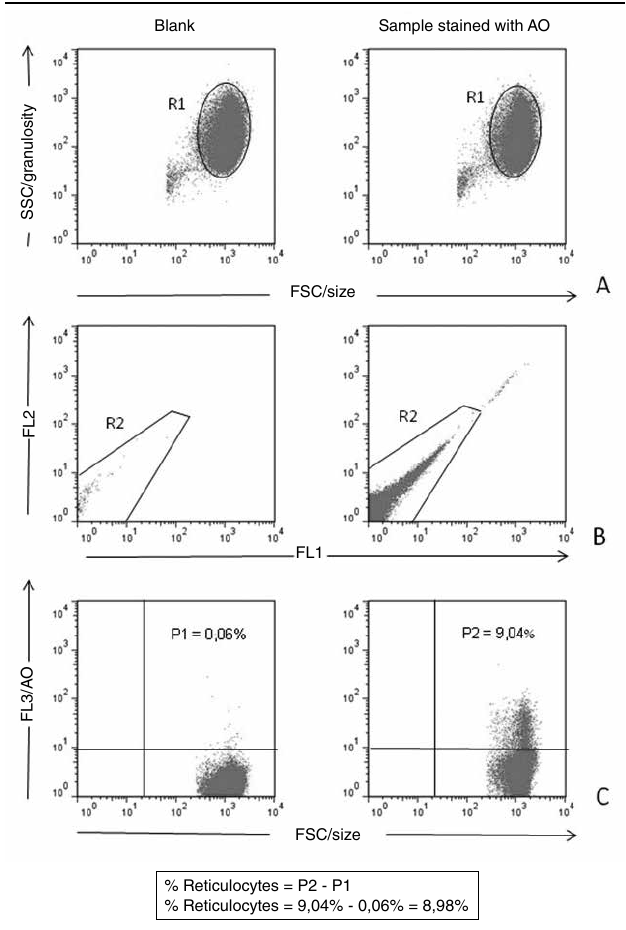
figurE 1 – Strategy for analysis of the reticulocyte enumeration by CF using AO A) selection of the population of interest based on morphological aspects (R1); B) selection of the homogeneous population (R2), excluding possible interfering factors; C) percentage quantification of positive cells in the upper right quadrant for the population of selected cells from the proposed gate (R1 and R2) FC: flow cytometry; AO: acridine orange; SSC: side scatter channel; FSC: forward scatter